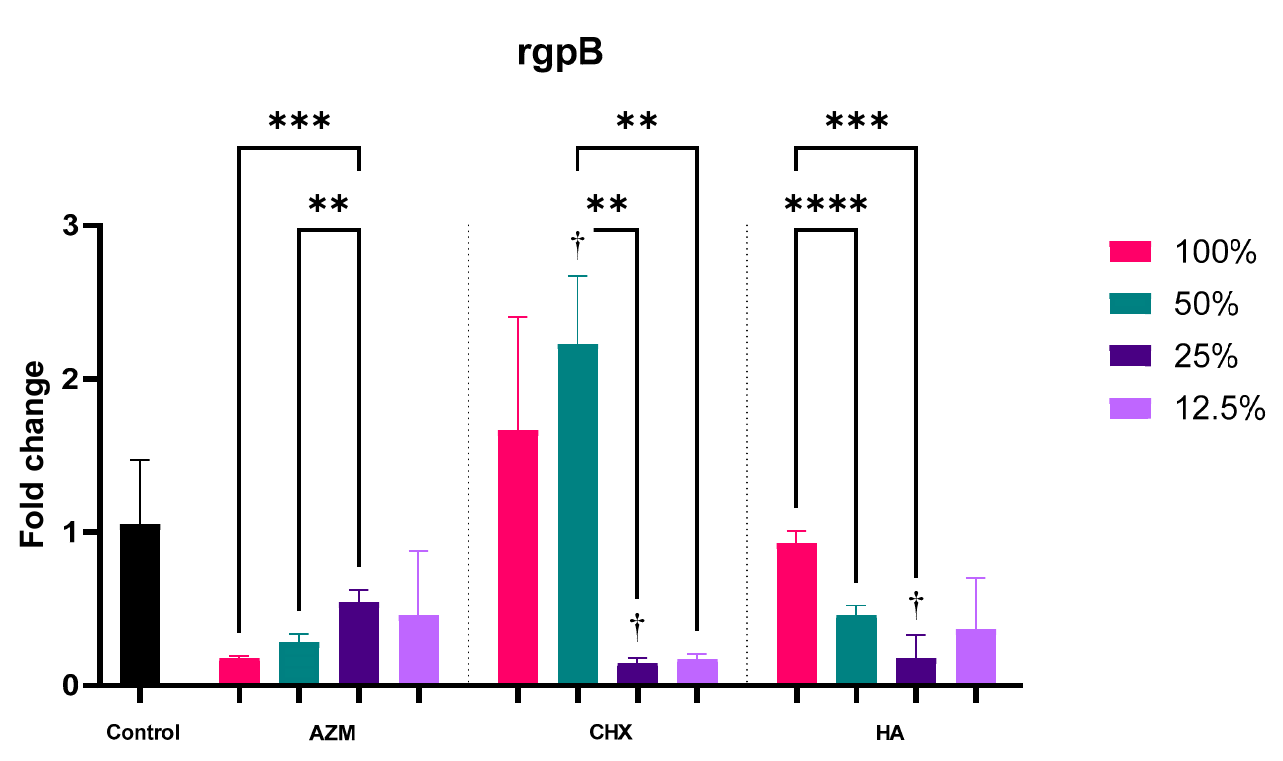
Figure 8. Fold-change values (mean ± SD) of different concentrations on expression of rgpB. >0.05 (ns), ≤ 0.05 (*), ≤ 0.01 (**), ≤ 0.001 (***), ≤ 0.0001 (****). Statistically significant compared to control p < 0.05 (†).